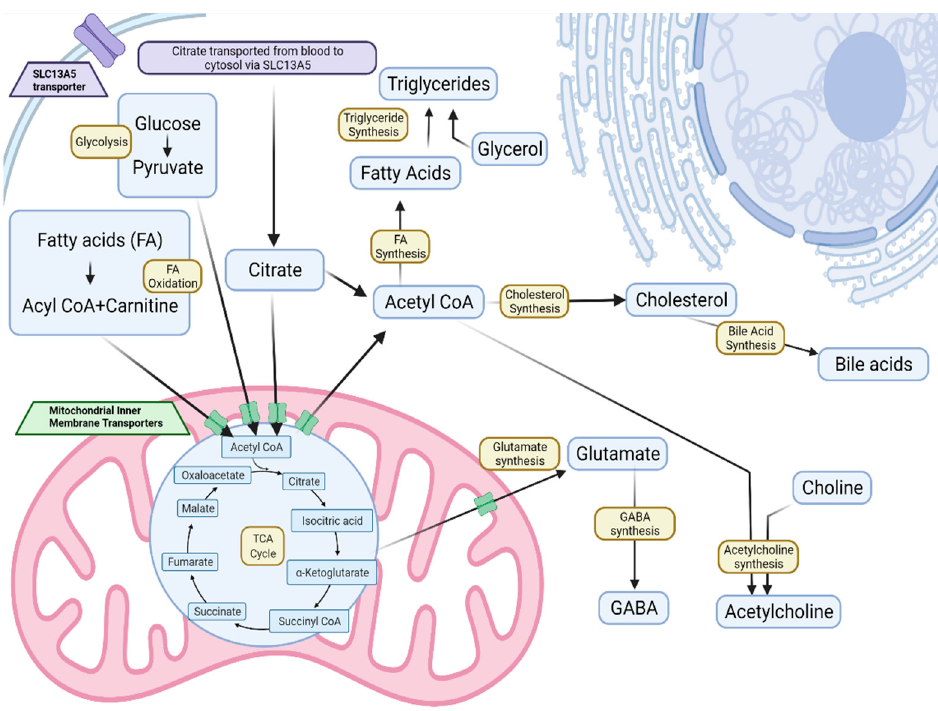
Figure 1. SLC13A5 transport of citrate is critical for lipid synthesis, storage, and utilization. Extracellular citrate is moved into cells where it is converted to acetyl-CoA for lipid synthesis or enters the TCA cycle [27] .